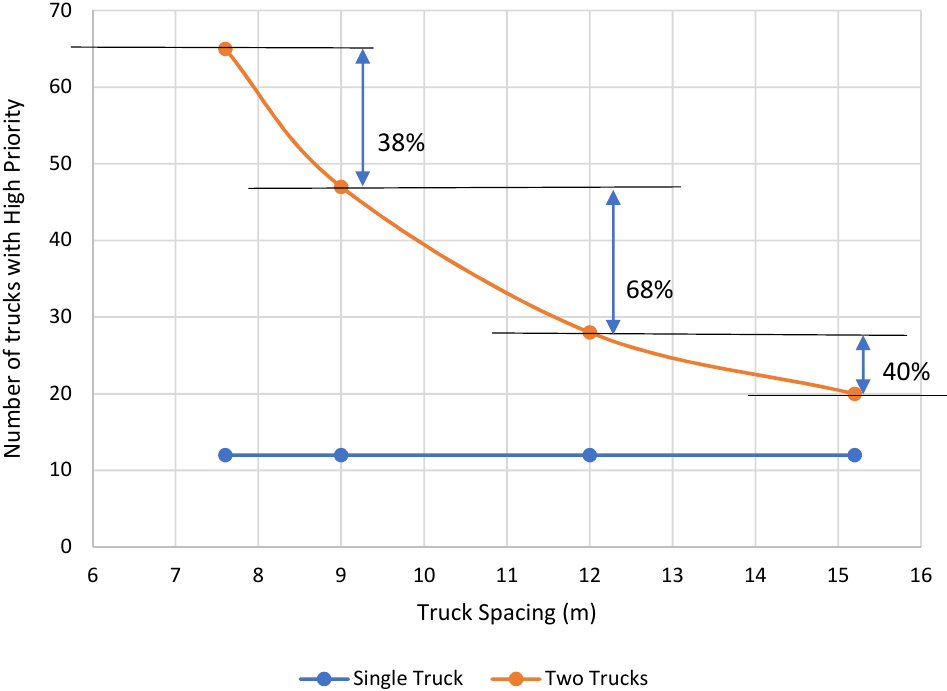
Figure 15. Number of high priority bridges for truck type 3S2 at different truck spacing for a single truck and for a platoon of two trucks (adopted from [105]).